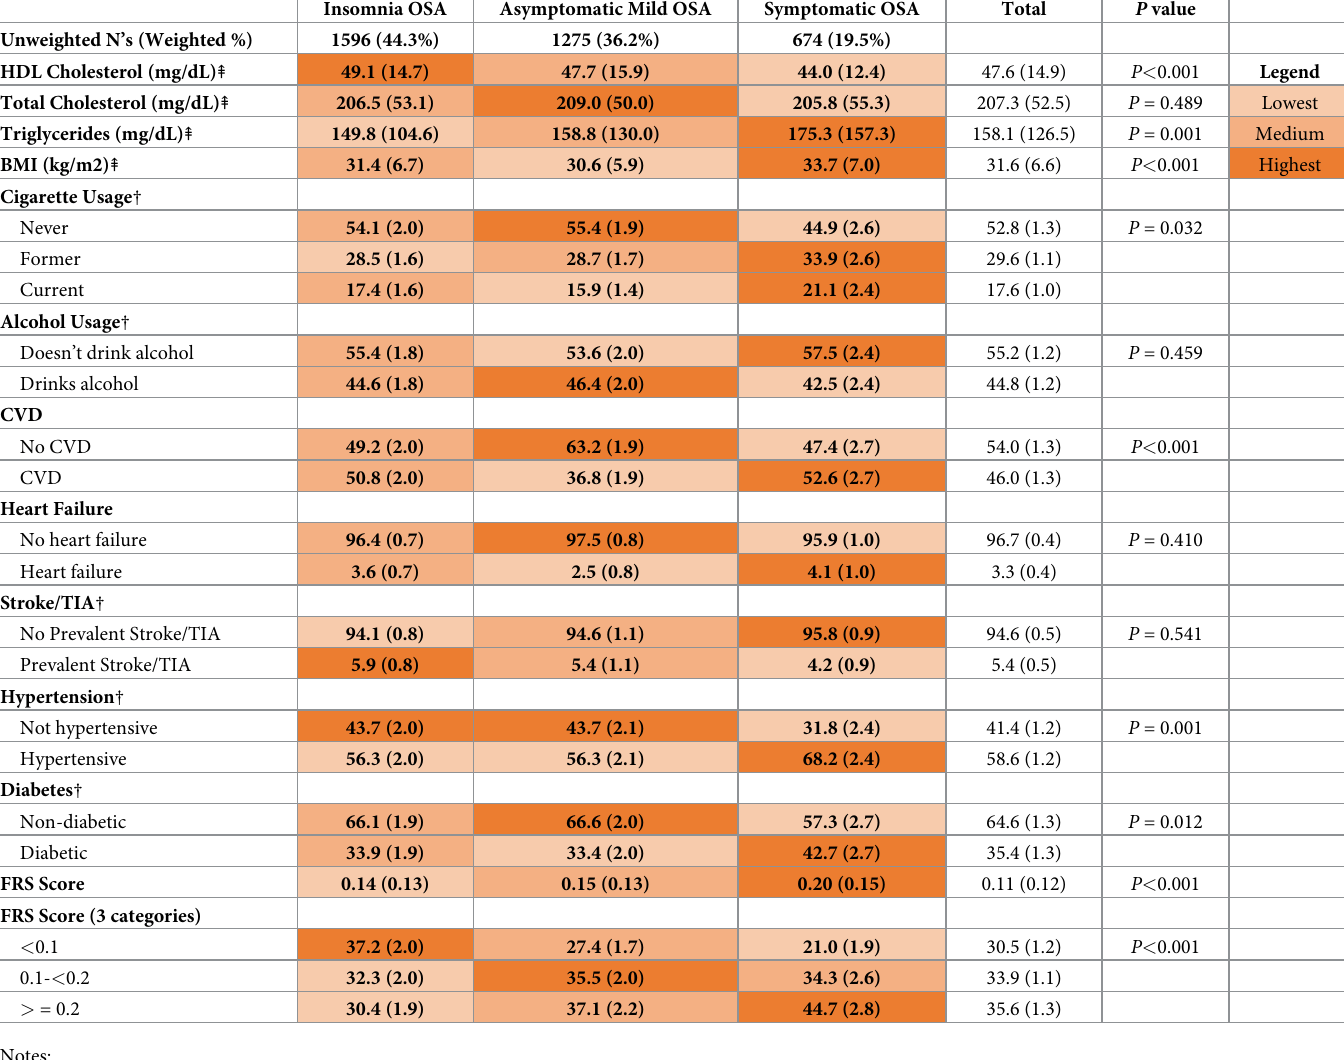
Table 3. Baseline cardiovascular characteristics of HCHS/SOL individuals by primary solution derived sleep